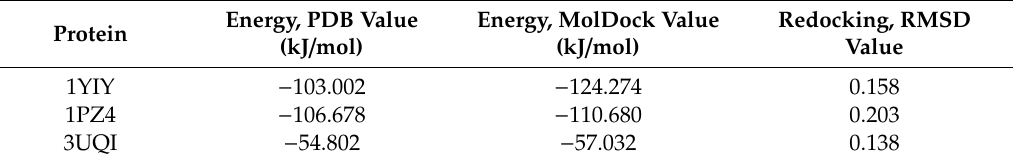
Table 3. The docking energy (kJ / mol) of the ligand for each protein from the Protein Data Bank (PDB), ligand energy of the MolDock score and the RMSD values obtained from the redocking procedure.